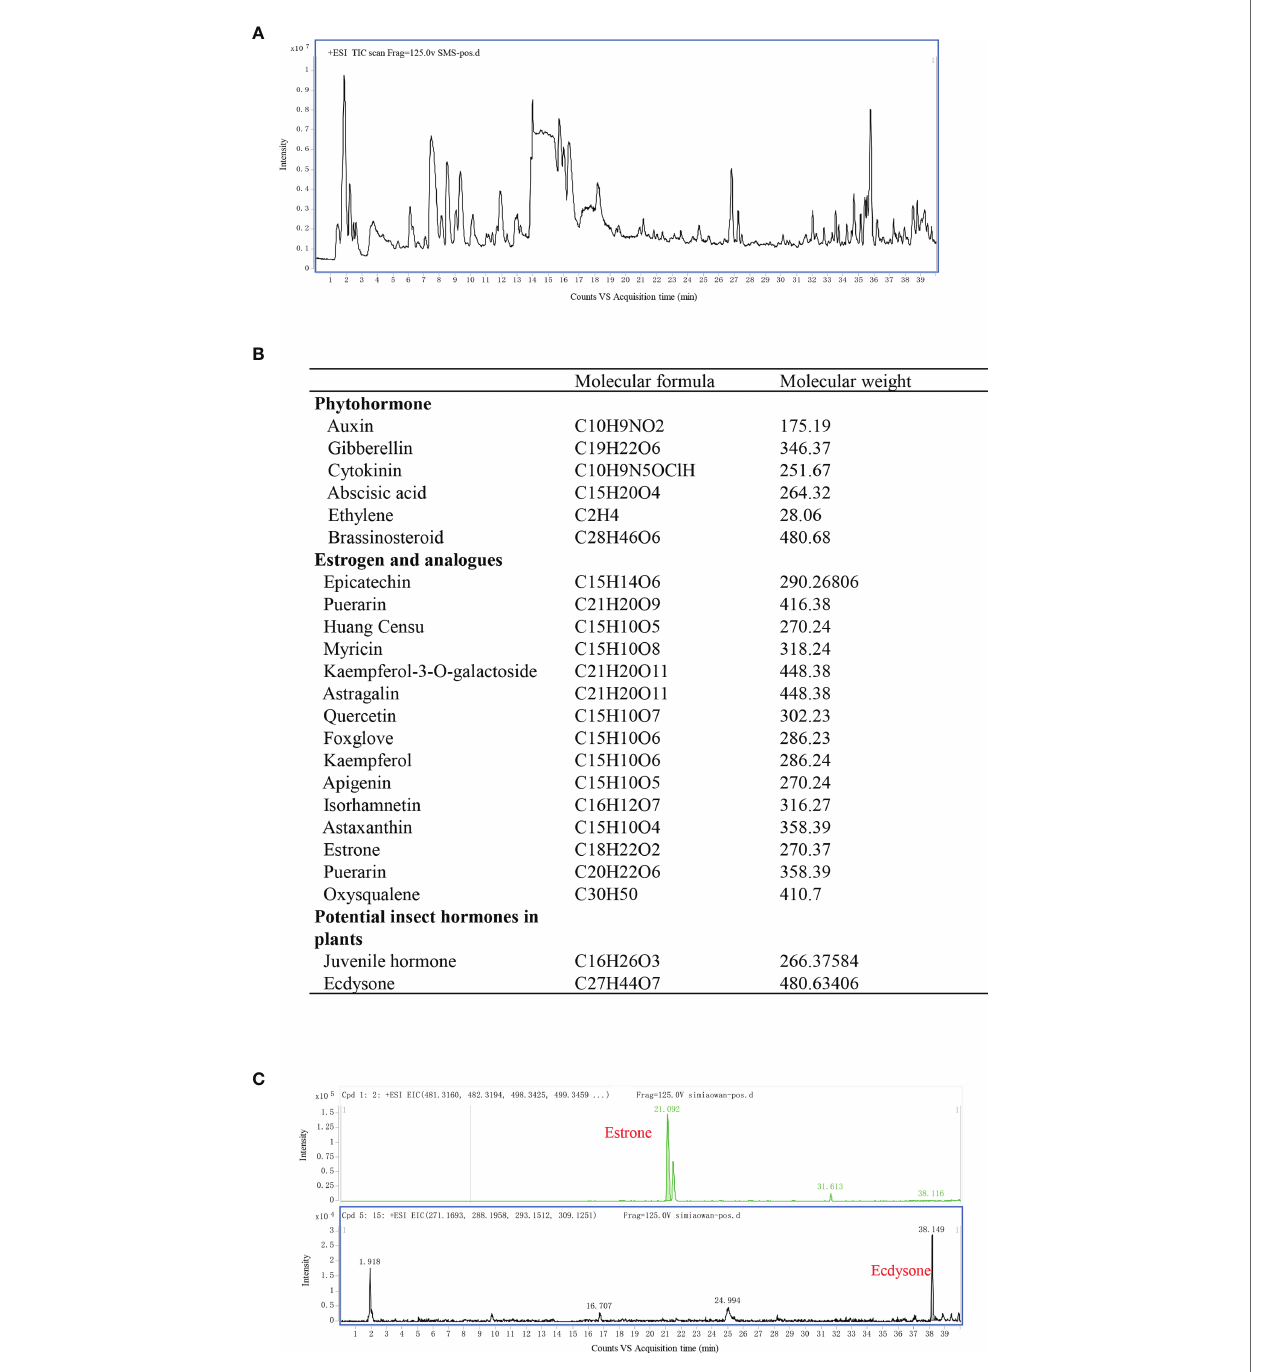
FIGURE 5 | Ecdysone and estrone detected in SMS via mass spectrometry. Total Ion Chromatography of SMS was detected by mass spectrometry (A) . Common phytohormone, estrogen and its analogs, and other potential hormones in plants to be screened in our study are listed (B) . Ecdysone and estrone were detected in SMS (C)